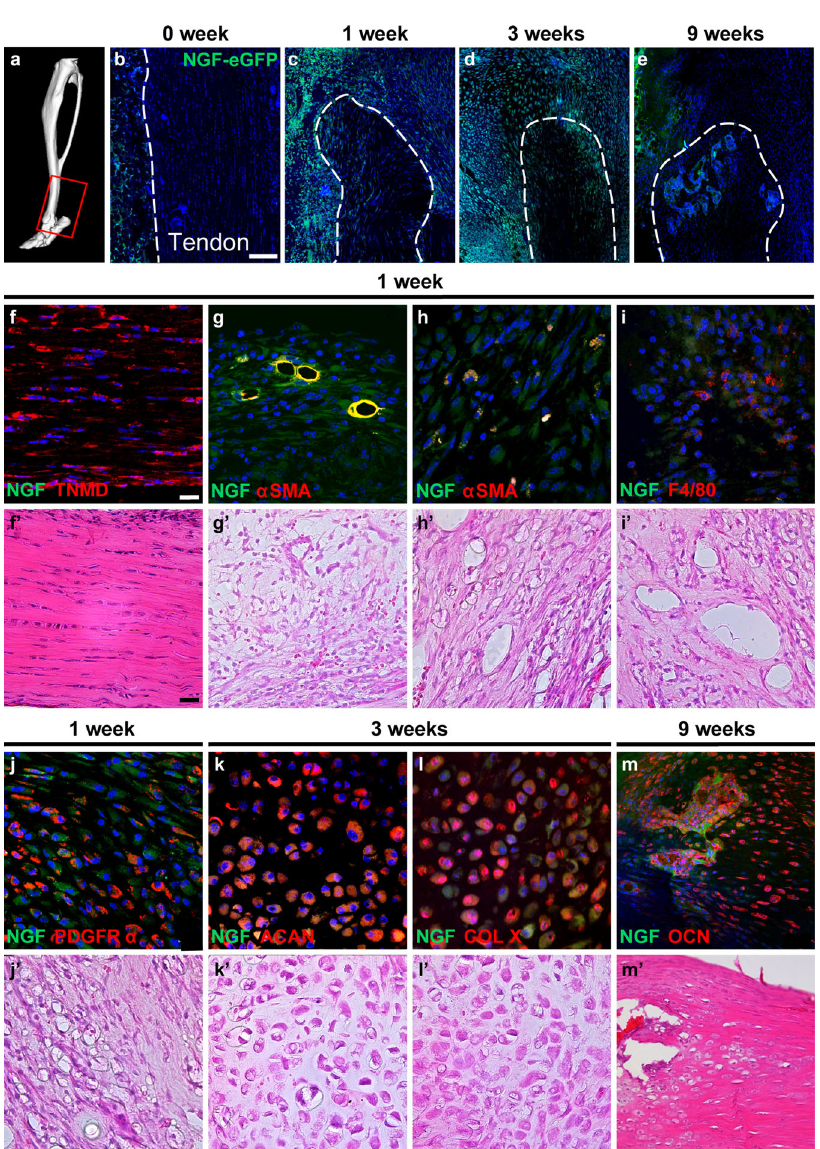
Fig. 4 NGF-eGFP reporter activity during heterotopic ossi fi cation (HO). NGF-eGFP reporter animals were subjected to HO induction and analyzed at 1, 3, and 9 weeks post injury. a μ CT reconstruction demonstrating the location of histology at the distal tenotomy site. The red box represents the region of interest. b – e Representative tile scans of NGF-eGFP reporter activity within the distal tenotomy site at 1, 3, and 9 weeks post injury. Reporter activity appears green, while nuclear counterstain appears blue. Uninjured control is shown for comparison. Dashed white lines indicate margins of the Achilles tendon. White scale bars: 100 μ m. f – m Cell sources of NGF, using immunohistochemical analysis of NGF-eGFP reporter sections. For all images, immunohistochemical staining appears red or yellow, while NGF reporter activity appears green. Nuclear counterstain appears blue. Corresponding H&E images are shown below ( f' – m' ). f – j Analyses at 1 week post injury, including f tenomodulin (TNMD), g , h smooth muscle actin (SMA) among perivascular cells ( g ) and non-vascular fi broblastic cells ( h ), i platelet-derived growth factor receptor- α (PDGFR α ), and j F4/80. k , l Analyses at 3 weeks post injury, including k Aggrecan (ACAN) and ( l ) Type X Collagen (Col X). m Analysis at 9 weeks post injury, including osteocalcin (OCN). White and black scale bars: 50 μ m. N = 3 animals per